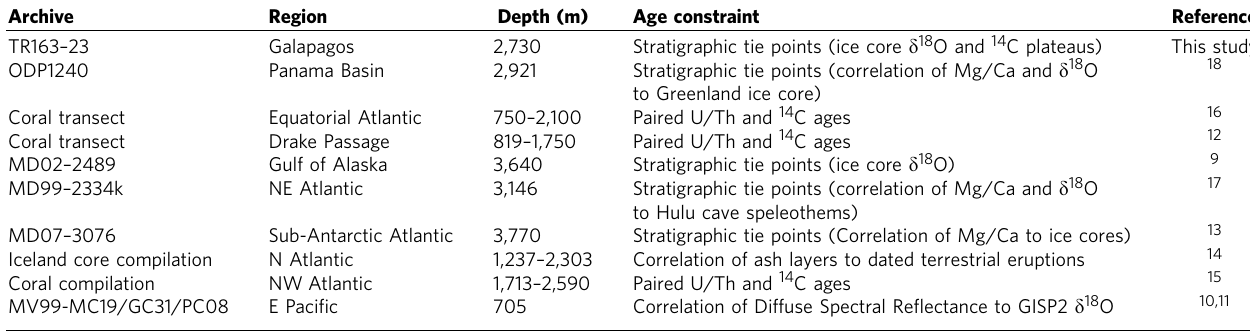
Table 1 | Method of age model constraint for cited radiocarbon